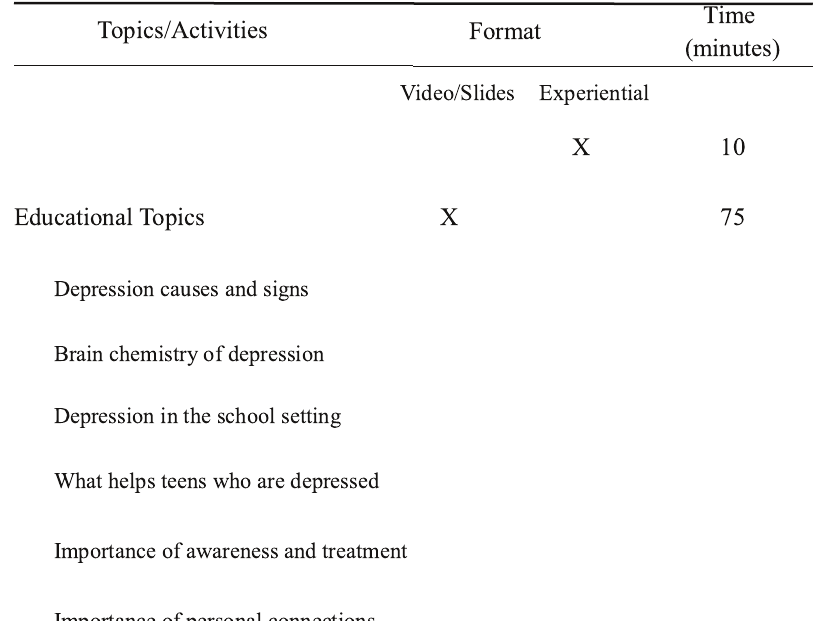
Description of“It’s Time!”